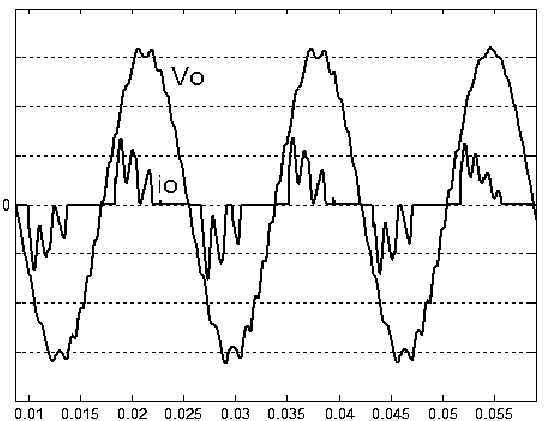
Figure 4. Output voltage and current for simulation of the proposed solution at full load (vertical: 50 V/div and 15 A/div).